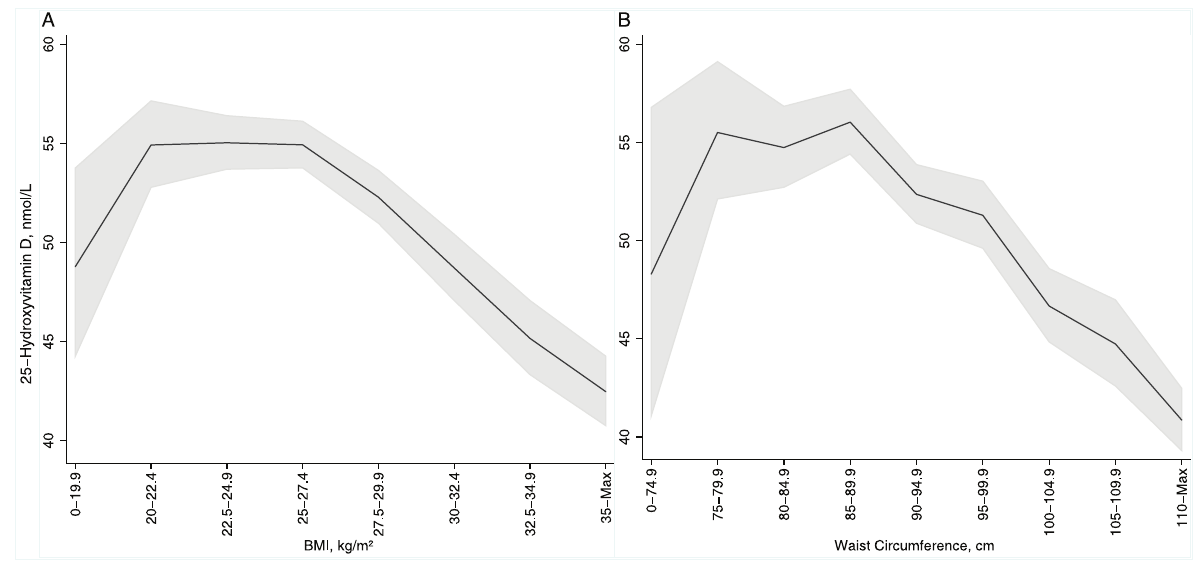
Figure 1. Variation in the average 25(OH)D concentration by body mass index (A) and waist circumference (B). Values are geometric means (95% confidence intervals) standardized by sex.